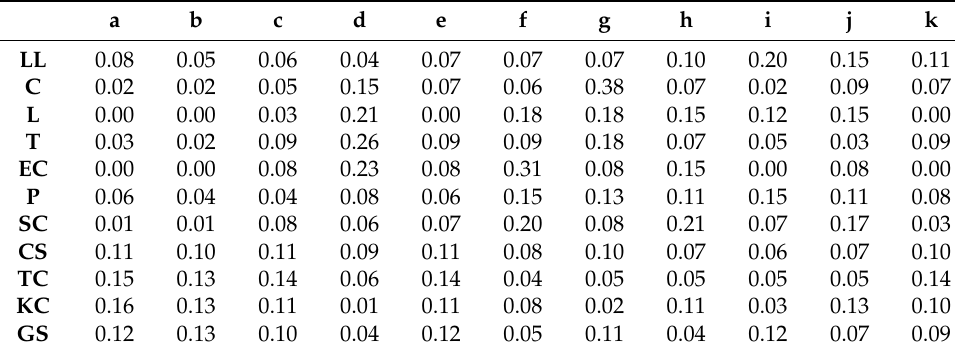
Figure 4. Snippet of the annotated PEOs-SOs dataset. Table 2. PEOs vector space representation (features